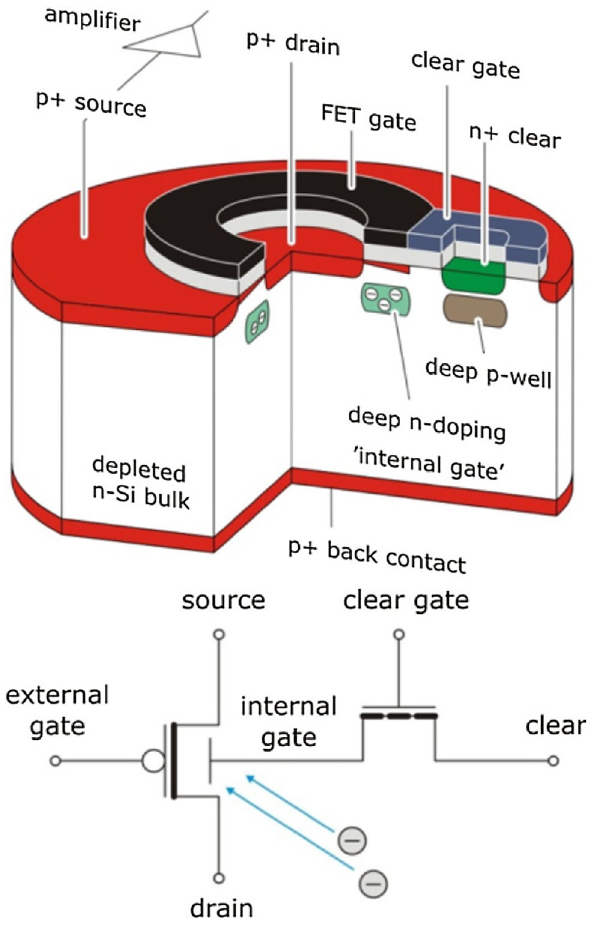
Fig. 3 Structure (top) and circuit representation (down) of a conven- tional spectroscopy-grade DEPFET cell